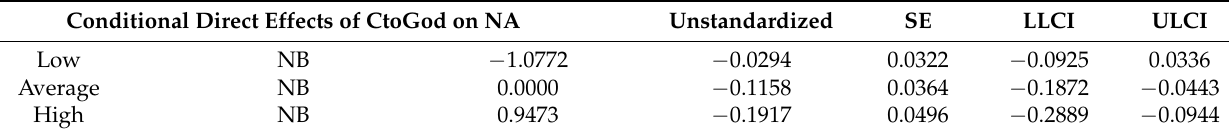
Table 6. Direct and indirect effects of closeness to God on negative